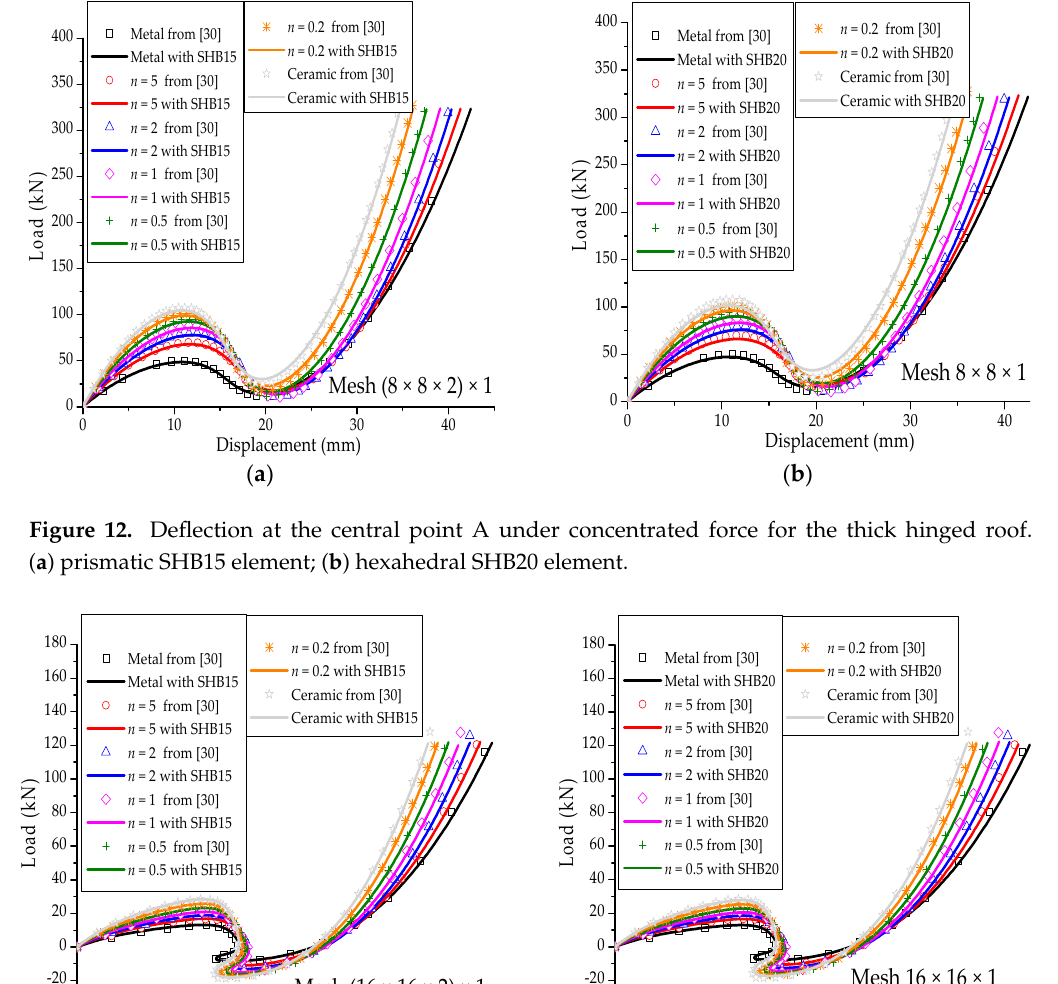
Figure 13. Deflection at the central point A under concentrated force for the thin hinged roof. ( a ) prismatic SHB15 element; ( b ) hexahedral SHB20 element.